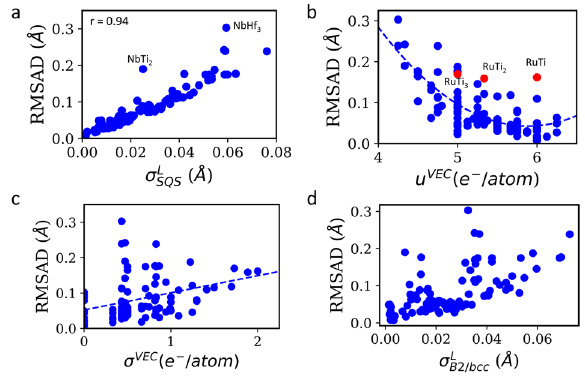
Fig. 2 Correlations between the root-mean-squared atomic displacement (RMSAD) parameter and fundamental properties of atomic bonds in refractory solid-solution alloys. a RMSAD vs. standard deviation of lengths of the fi rst-nearest neighbor (FNN) ); b RMSAD vs. average atomic bonds in the relaxed SQS ’ s ( σ L SQS valence electron concentration ( u VEC ); c RMSAD vs. standard deviation of the number of valence electrons of the constituent elements relative to VEC ( σ VEC ); and d RMSAD vs. standard deviation of atomic bond lengths estimated from single-element bcc and ) based on Eq. binary B2 crystals ( σ L B2 = bcc